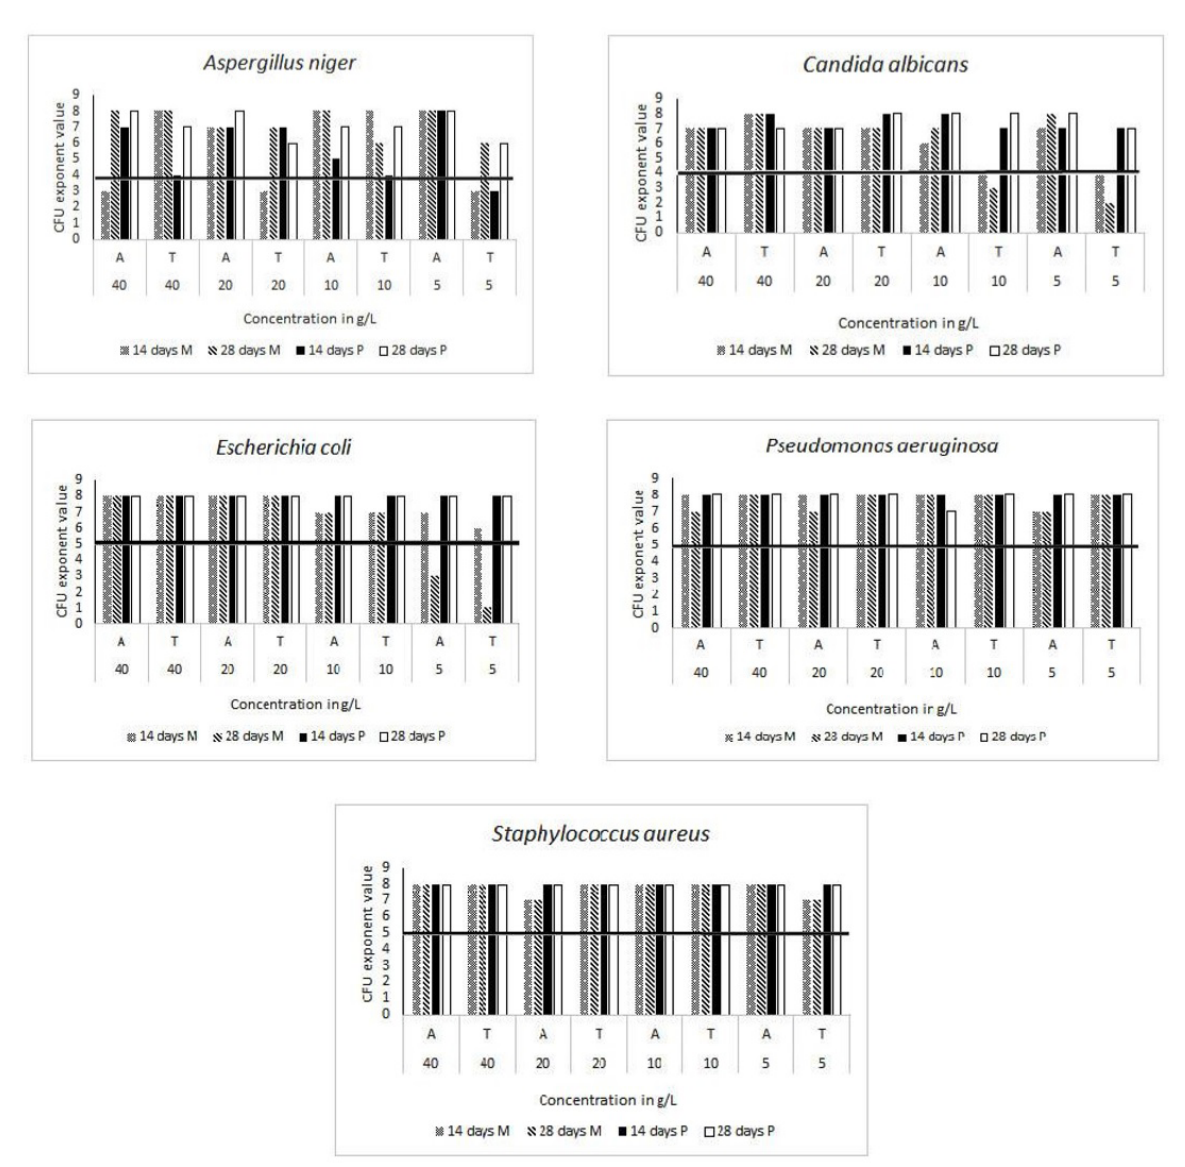
FIGURE 1 - Effect of preservatives methylparaben (M) (0.2%) and PMEPBI (P) (0.2%), in the presence of nonionic surfactants PHCO (A) and PSO (T) at 5, 10, 20, and 40 g L -1 , on microbial growth of five tests microorganisms after 28 days of